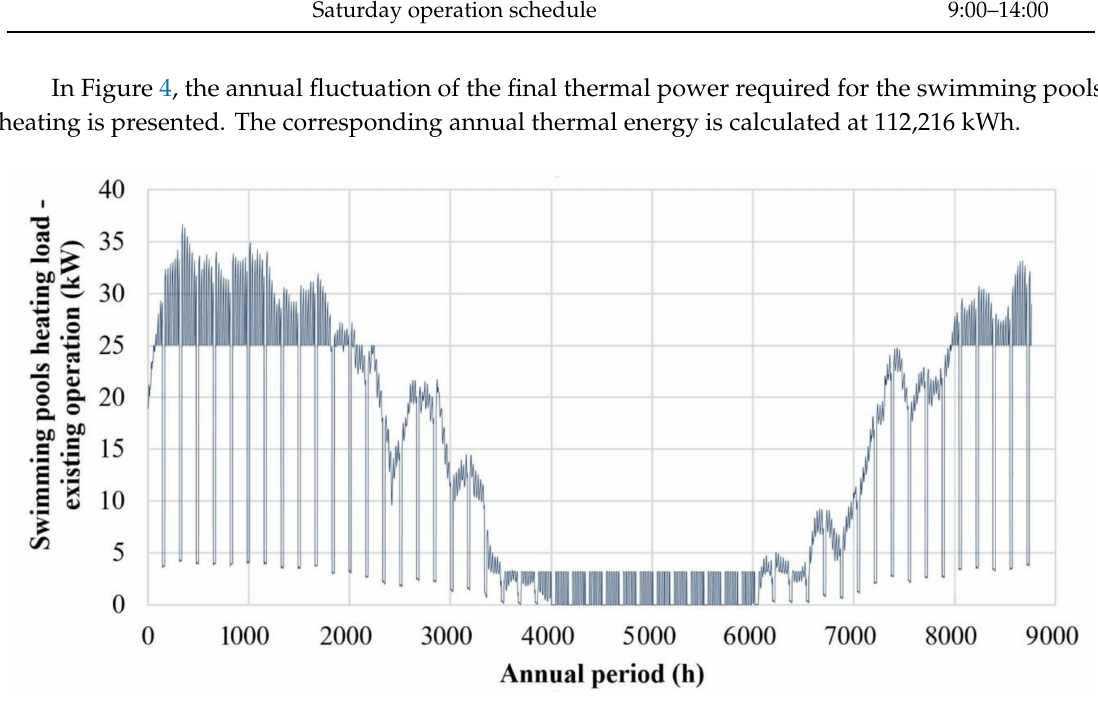
Figure 4. Annual fluctuation of the final thermal power required for the swimming pools